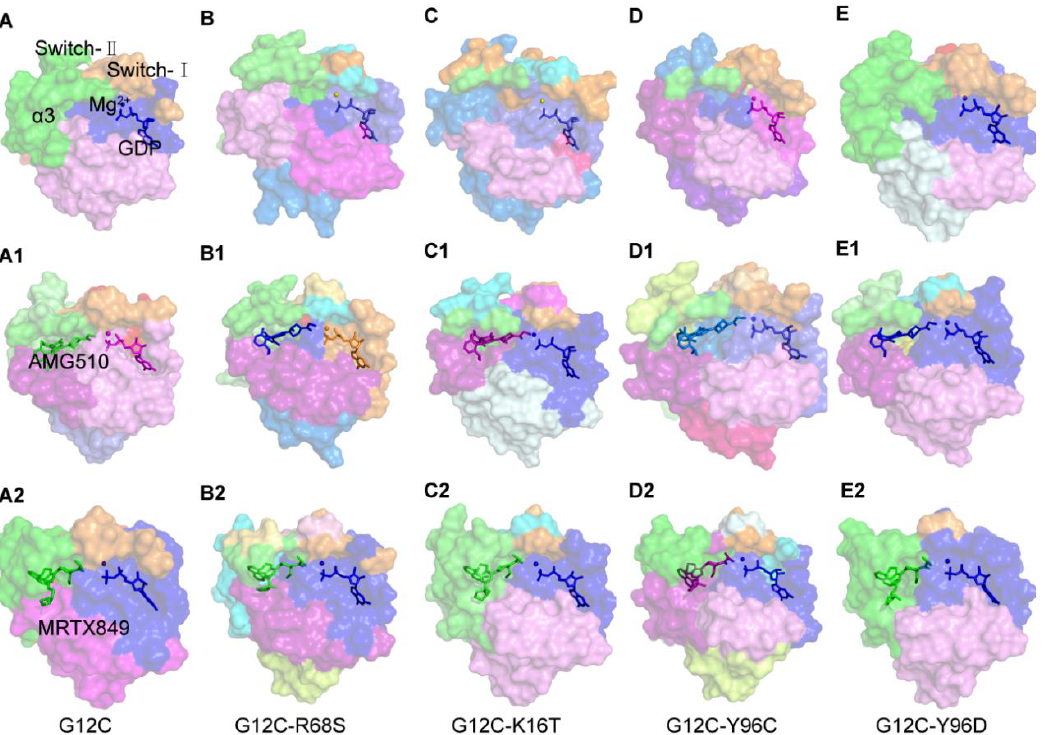
Figure 12. Communities distribution analysis for each simulated system. ( A – E ) Dynamical network analysis of apo form KRAS G12C, G12C-R68S, G12C-K16T, G12C-Y96C and G12C-Y96D. Dynamical network with AMG510 ( A1 – E1 ) and MRTX849 ( A2 – E2 ) of KRAS G12C, G12C-R68S, G12C-K15T, G12C-Y96C and G12C-Y96D protein, respectively. Each color denotes a different community.